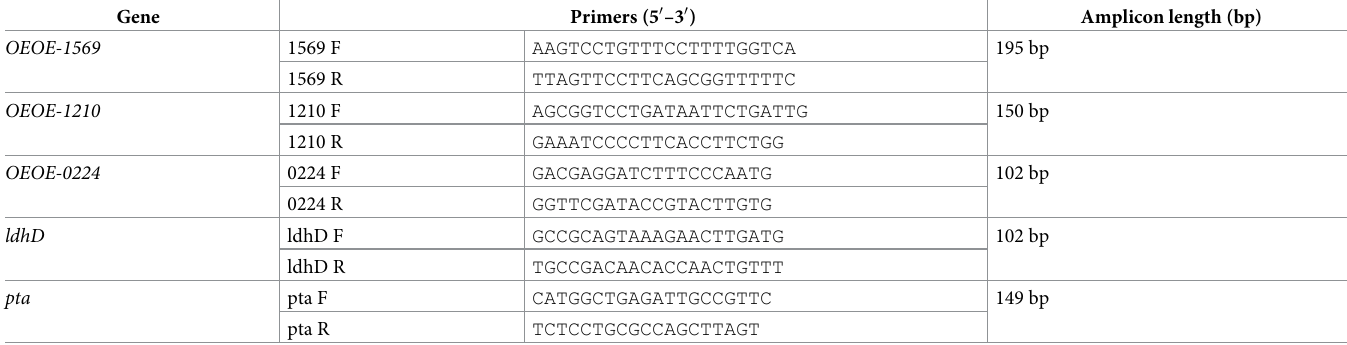
Table 1. Primers used for real